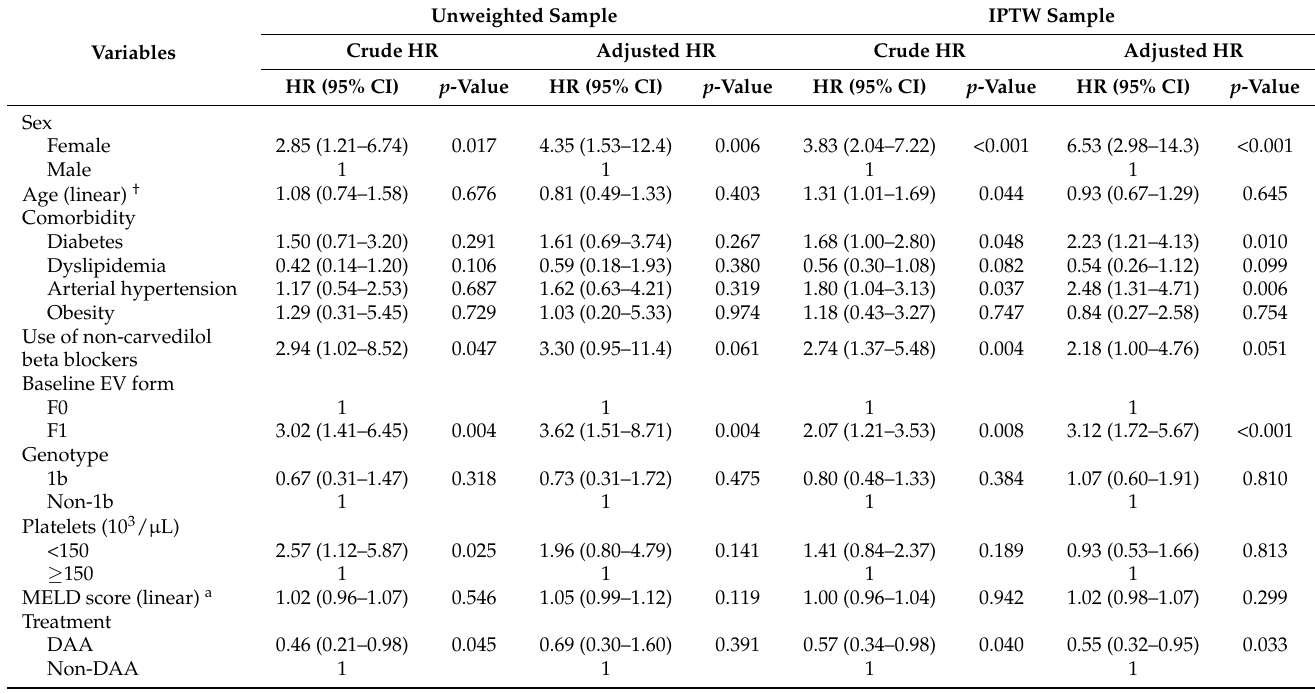
Table 3. Multivariable Cox proportional hazards model analysis of factors associated with EV progression in HCV patients with liver